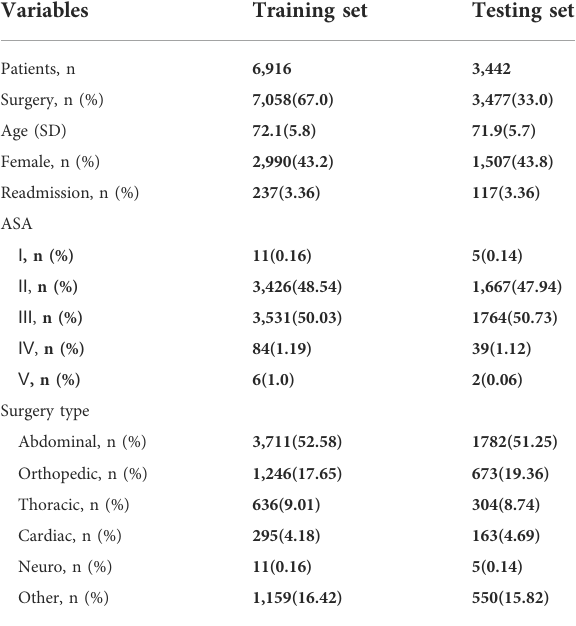
TABLE 1 Summary of demographic characteristics and perioperative data in this cohort.